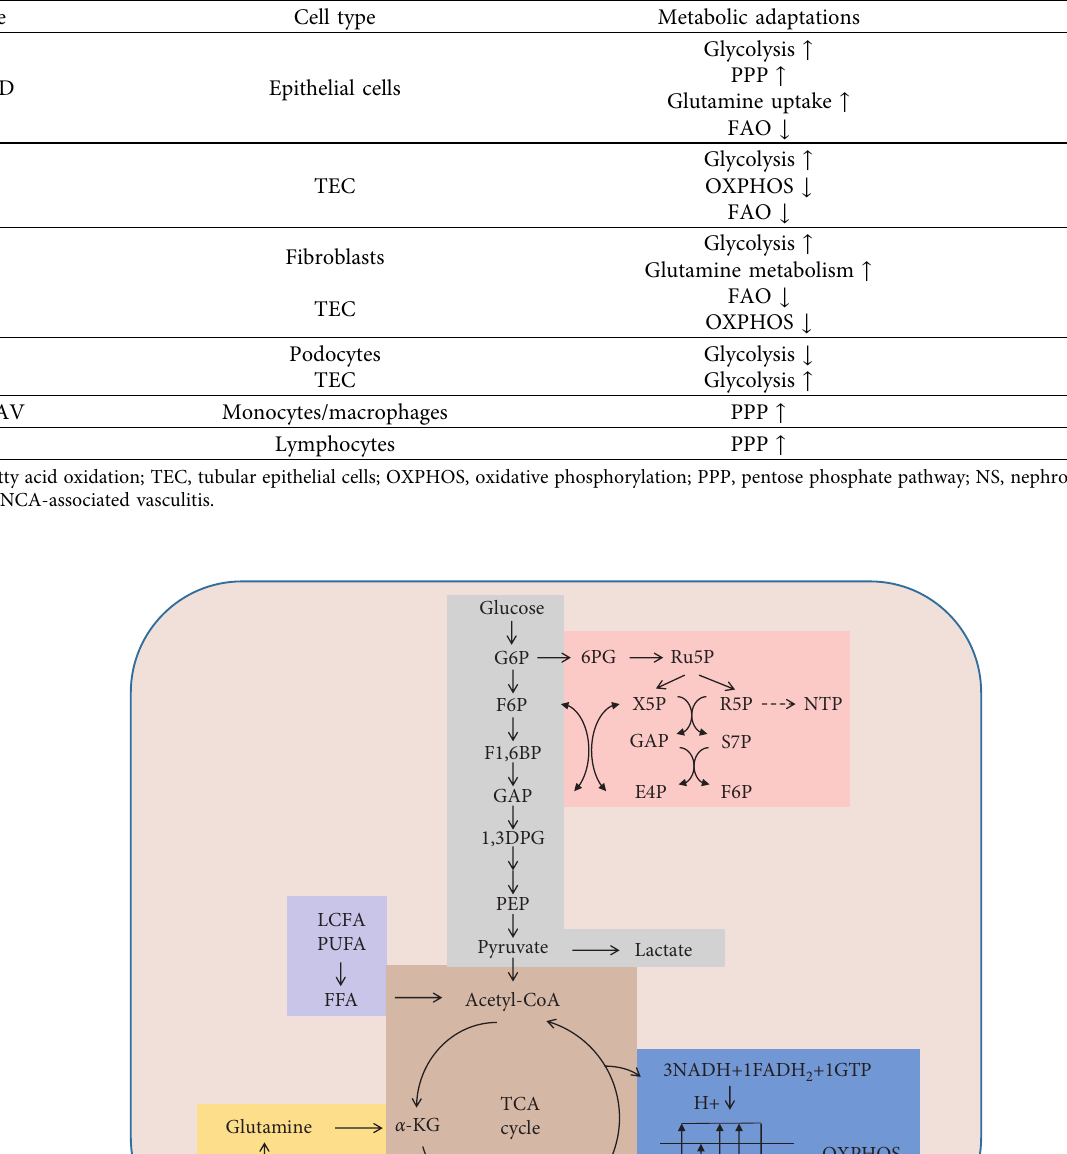
Table 1: Metabolic adaptations in various cell types of different kidney diseases.